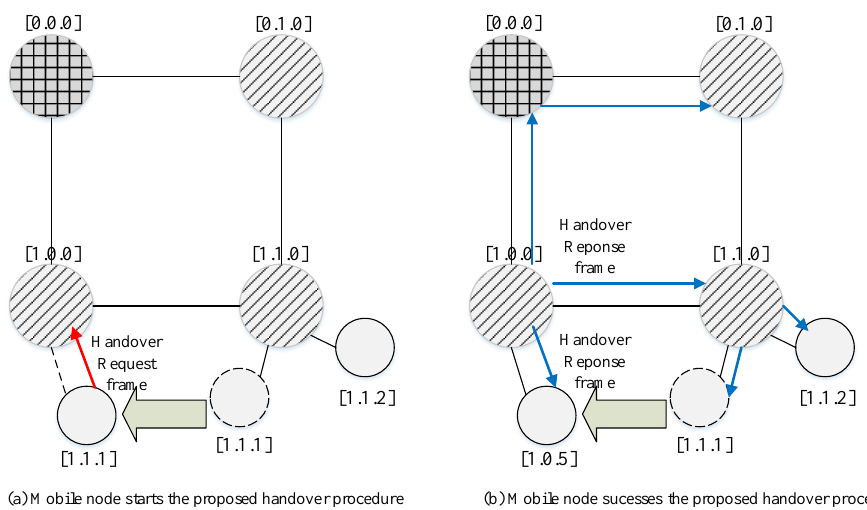
Figure 11. Example of the proposed handover procedure.